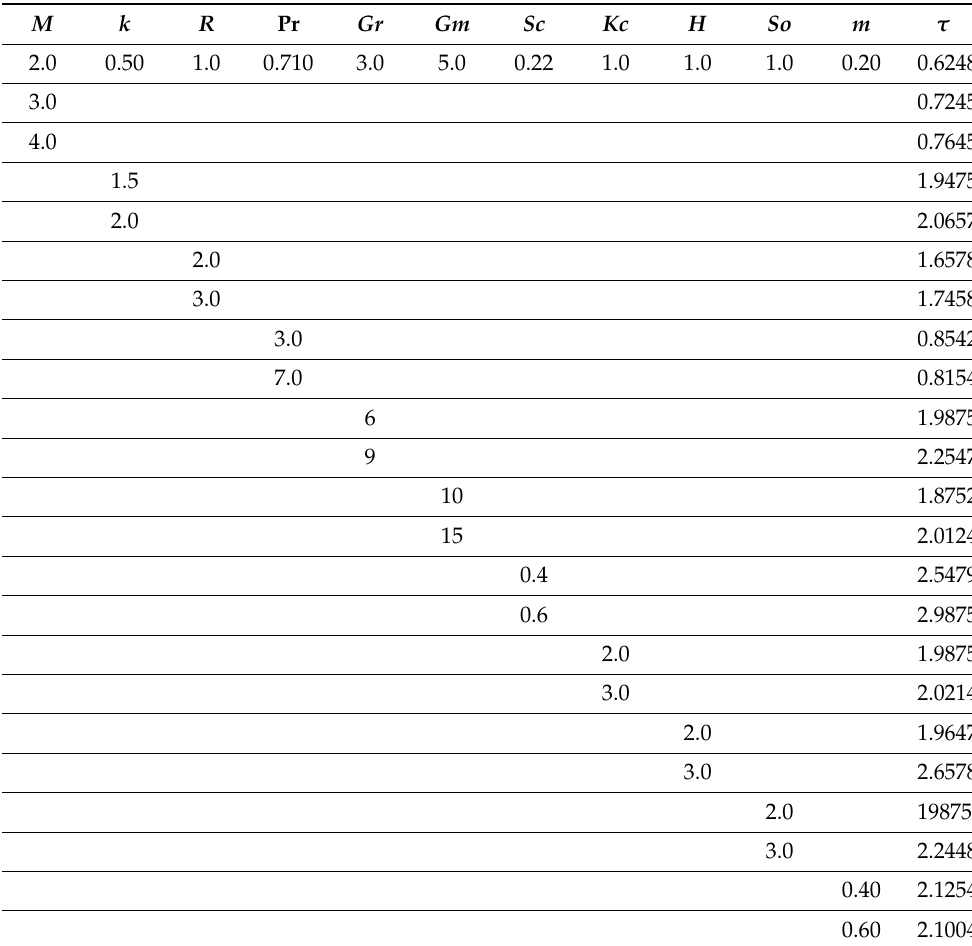
Table 1. The shear